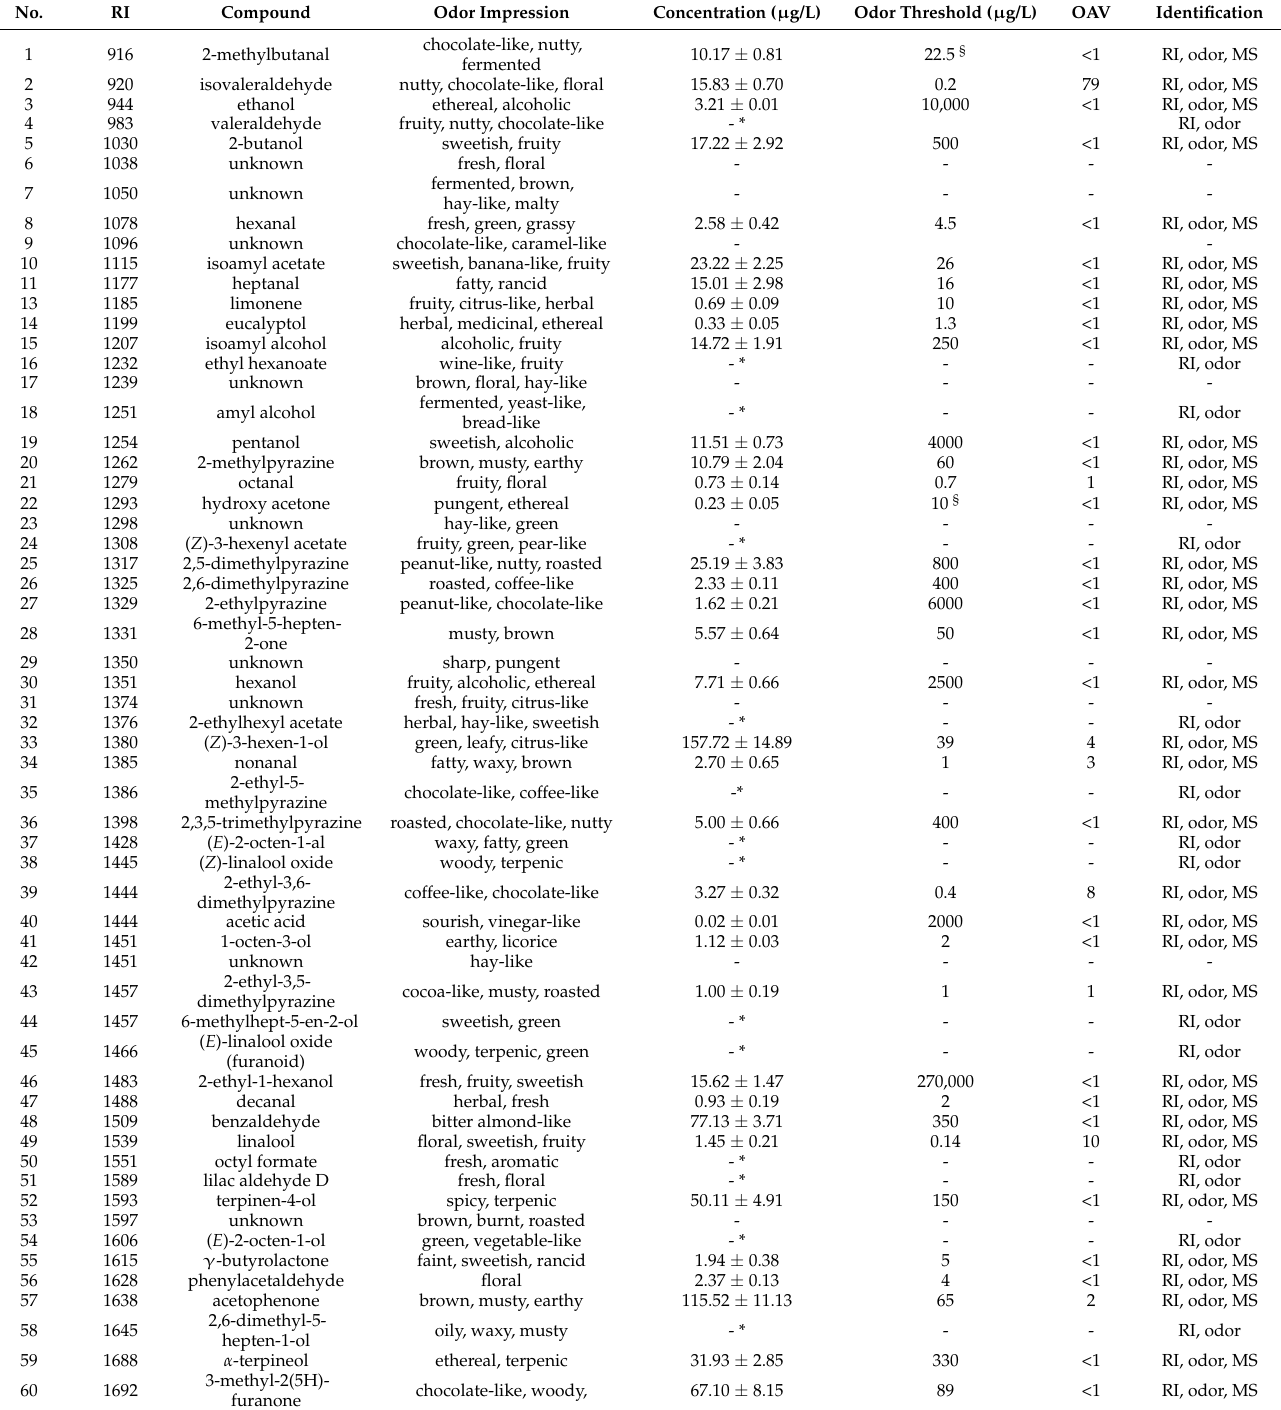
Table 2. Odor-active compounds identified in the fermented broth by means of